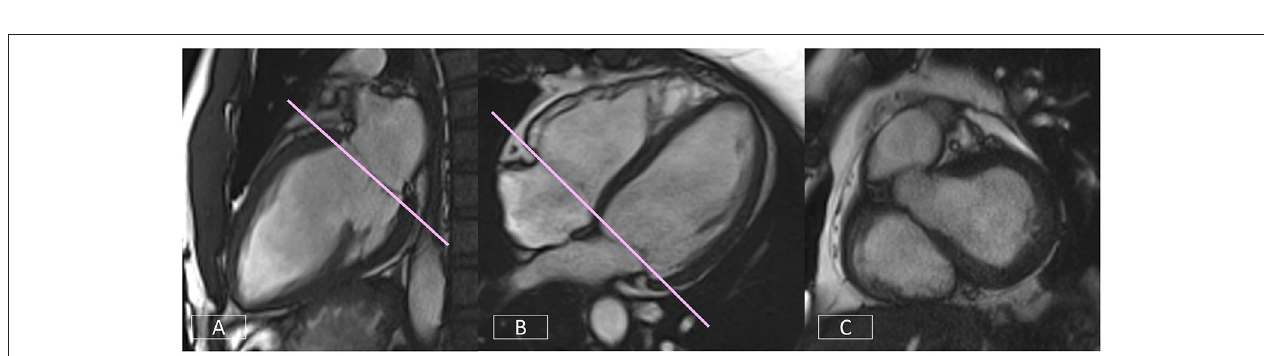
FIGURE 9 | Accurate positioning of the basal slice of the LV SAX series requires the use of both the LV VLA (A) and the 4-chamber (B) views to ensure the basal diastolic phase slice is positioned parallel to the mitral valve annulus, avoiding atrium and with an even amount of myocardium around the blood pool (C) .